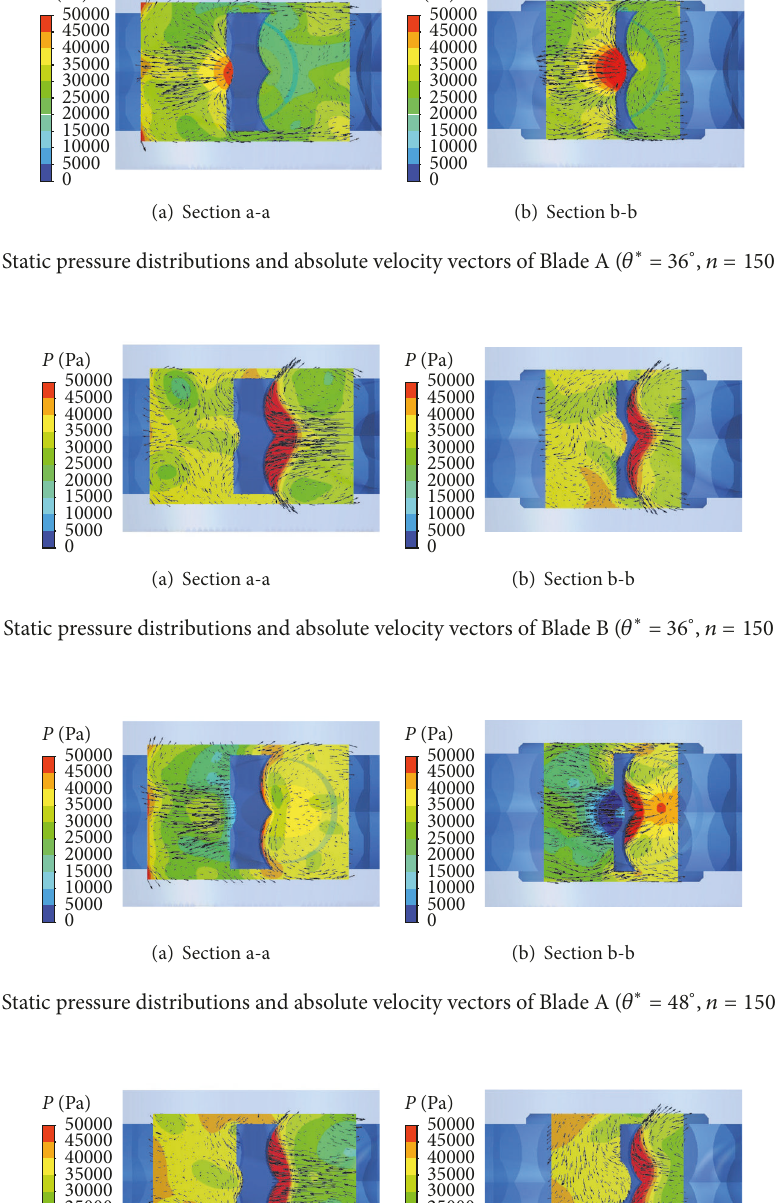
relative speed of the jet to the blade decreased. As shown in = 36 ∘ , static pressure at the back surface of Blade A increased